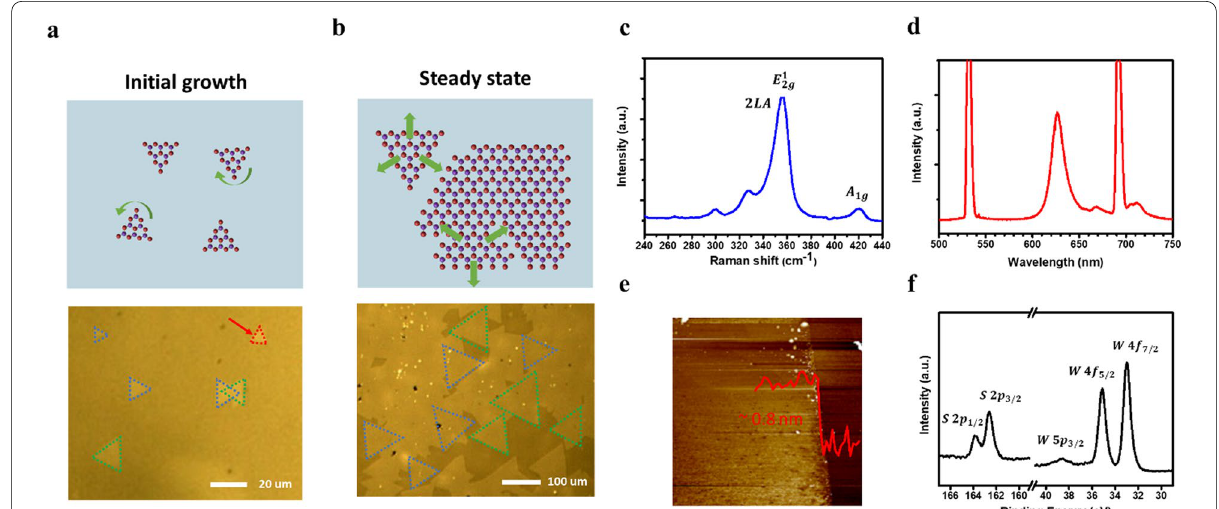
Fig. 1 The scalable epitaxial growth of highly‑oriented monolayer TMDs by customized CVD process. Schematics illustration of growth mechanism in the a initial growing stage and b steady state stage with related OM images. c Raman, d PL, e height profile and f XPS analysis of epitaxial monolayer WS